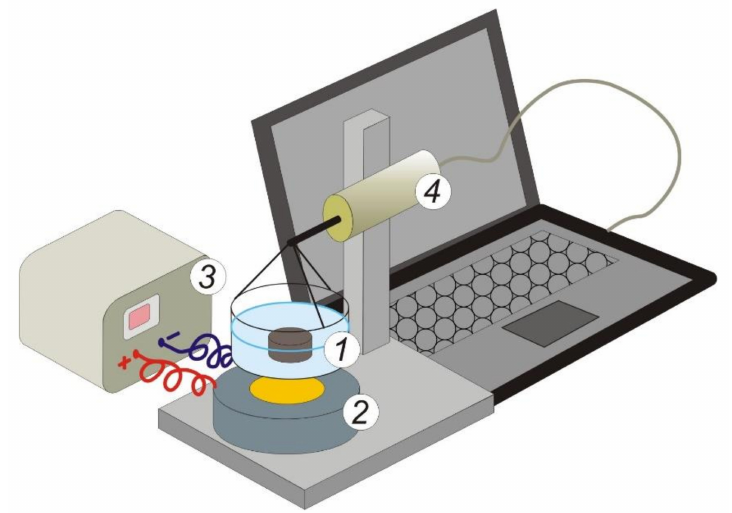
Figure 2. Schematic sketch of the experimental setup for measuring the mechanical force on ferrogel in a non-uniform magnetic field. ( 1 ) Cuvette with a ferrogel sample; ( 2 ) electromagnet; ( 3 ) stabilized power supply; ( 4 ) force transducer. See explanation in the